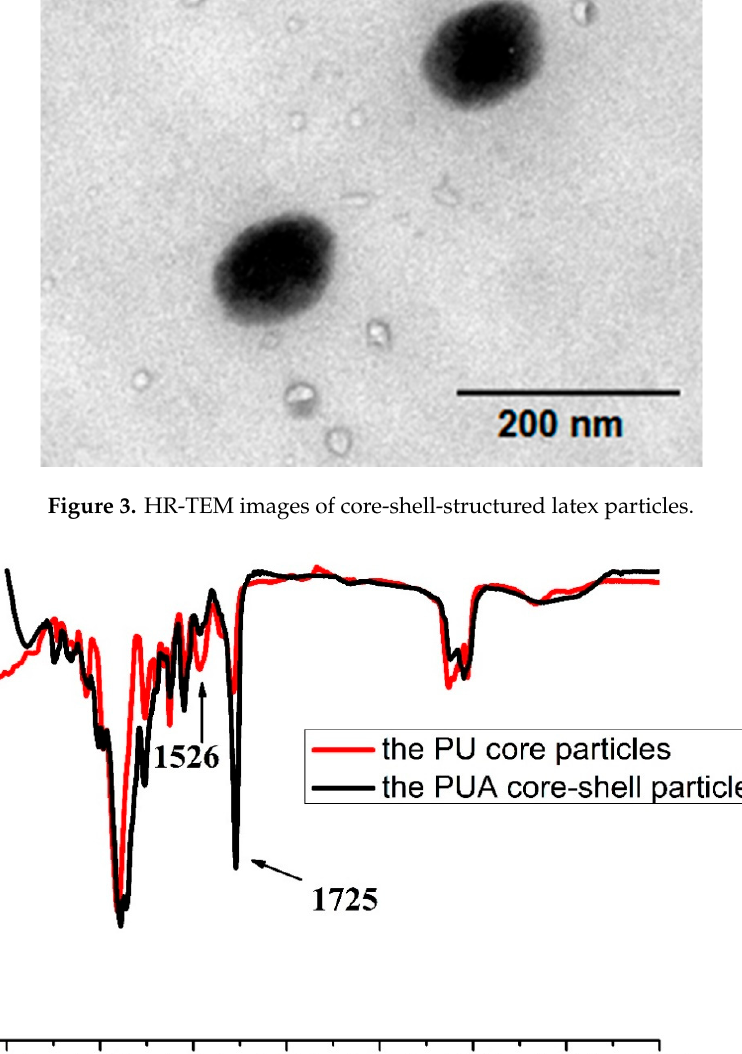
Figure 4. FTIR spectra of ( a ) the PUA core-shell particles and ( b ) the PU core particles.